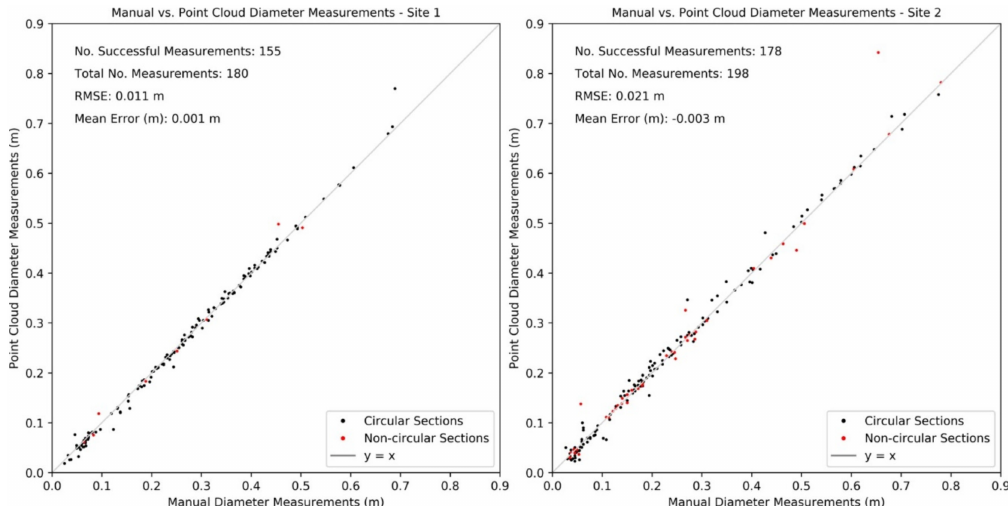
Figure 10. Scatter plots of manual diameter measurements obtained in the field using measuring tape- versus the point cloud-based diameter measurements for Site 1 ( Left ) and Site 2 ( Right ). Any measurements marked with the qualitative label of “noncircular” are shown as red points and would be expected to have greater error than the circular measurements.